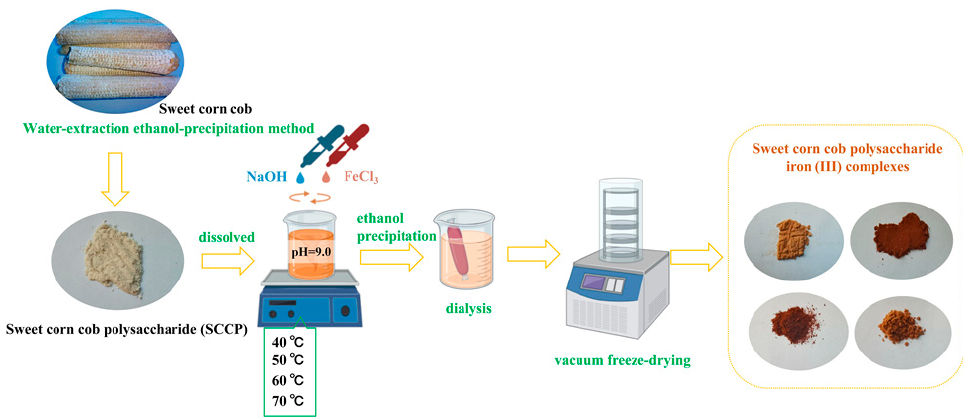
Figure 9. Schematic representation of the preparation steps for the sweet corn cob polysaccharide- iron (III) complexes. (III)